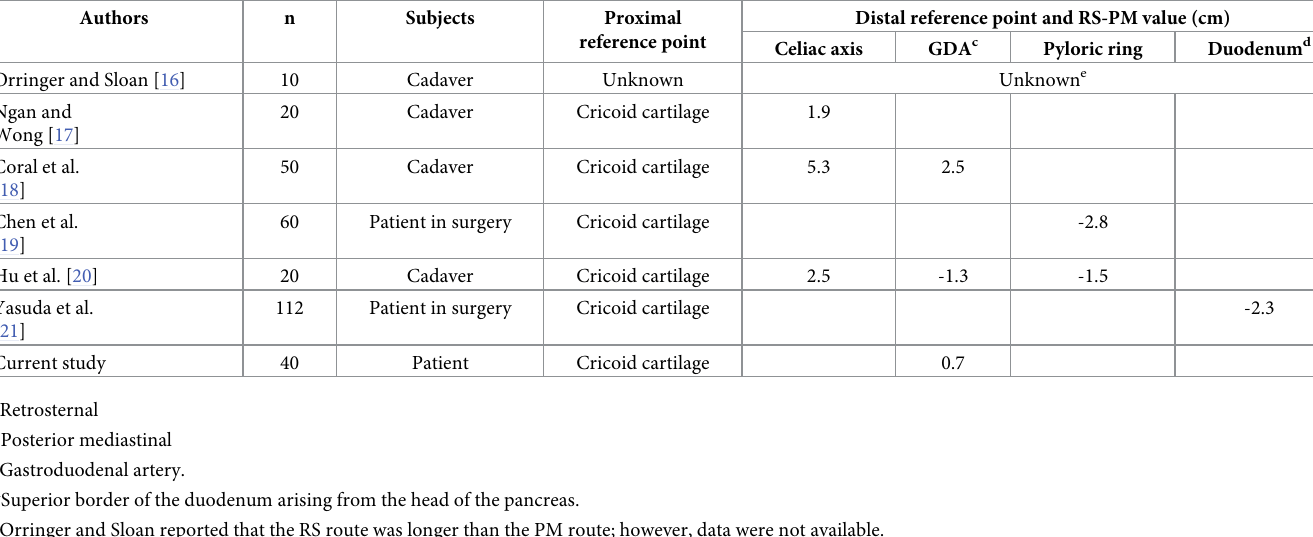
Table 4. Studies on the differences between RS a and PM b